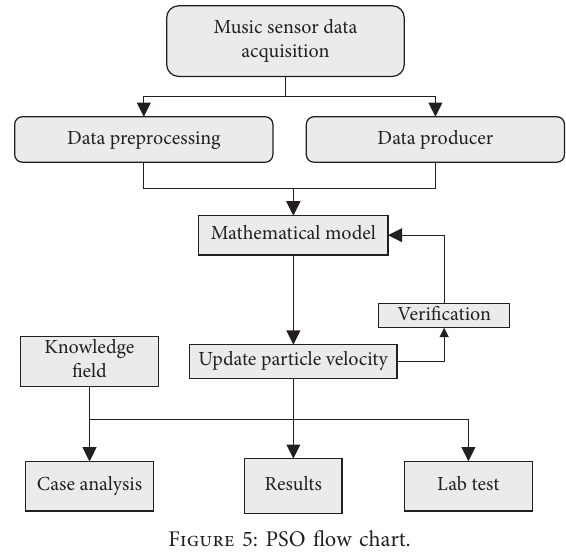
Figure 5: PSO flow chart.